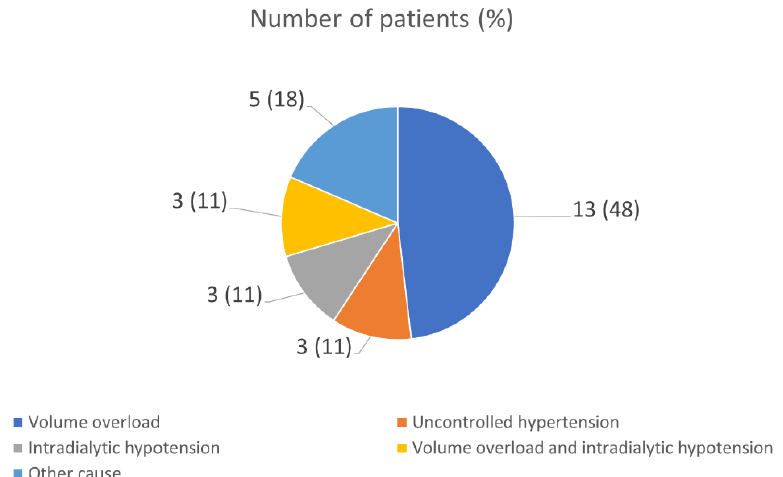
Figure 1. The causes of unsuccessful reductions in hemodialysis frequency. Other causes included uremic symptoms (two patients), alterations of consciousness during dialysis (two patients), and an uncomfortable feeling after the dialysis session (one patient). uncomfortable feeling after the dialysis session (one patient) .